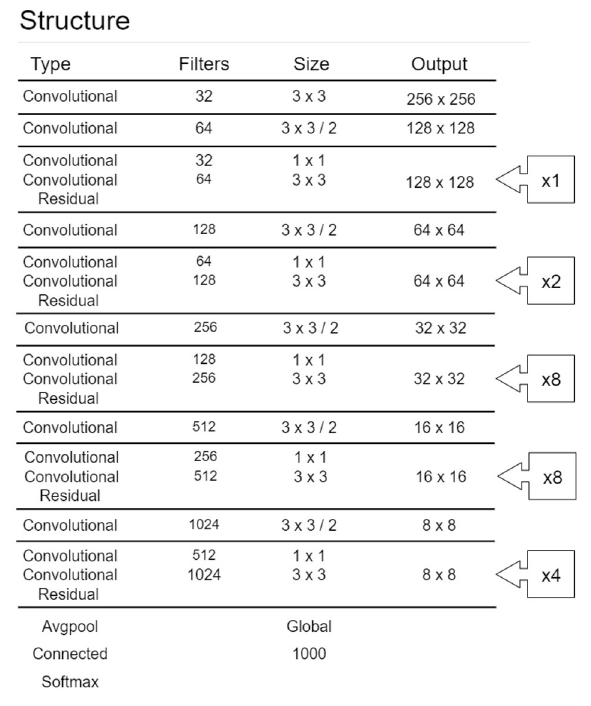
FIGURE 2 | YOLOv3_Darknet53 network (Redmon and Farhadi, 2018).